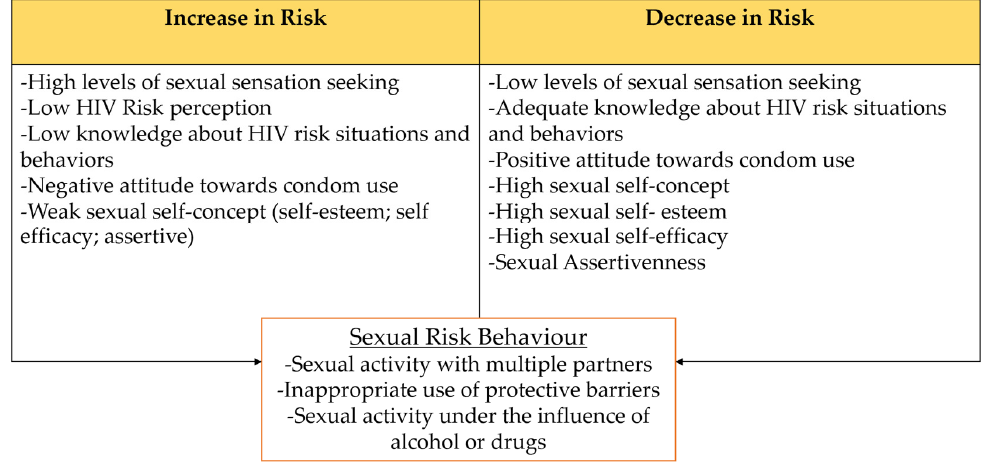
Figure 1. Theoretical relationships between dimensions of sexual risk behaviors and psychological factors.